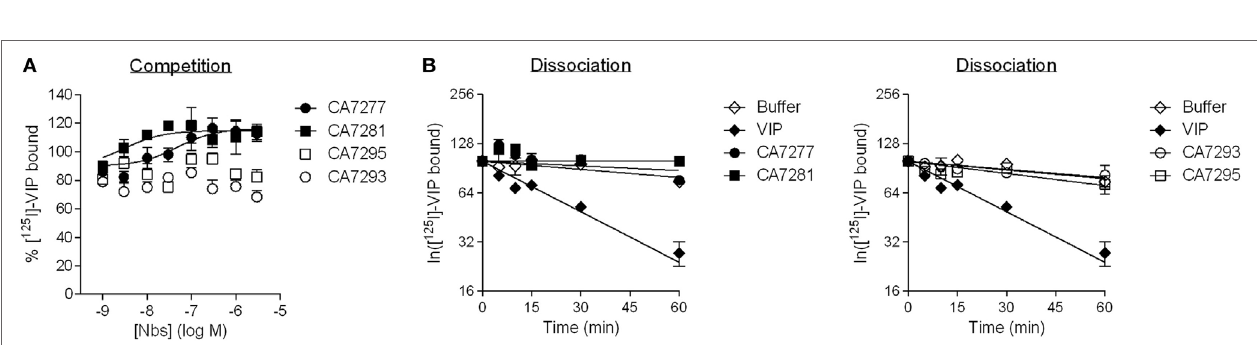
FigUre 2 | Nanobodies competition binding experiments. Binding of DyLight 650-conjugated CA7277 (a) and C7281 (B) on CHO cells expressing VPAC1 in presence of increasing concentrations of CA7277 (filled circles), CA7281 (filled squares), CA7293 (open circles), or CA7295 (open squares). The data represent the means ± SEM of three independent experiments performed in duplicate.